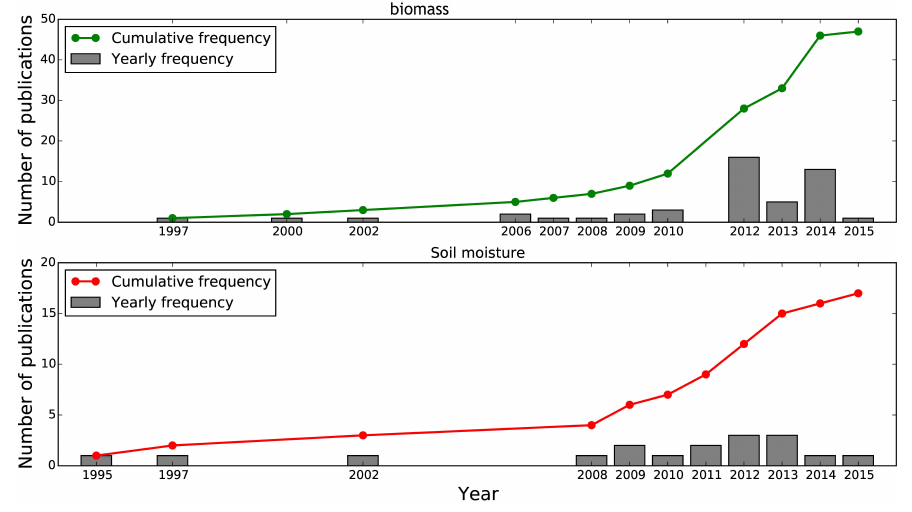
Figure 1. Cumulative frequency of remote sensing studies for biomass and soil moisture using machine learning